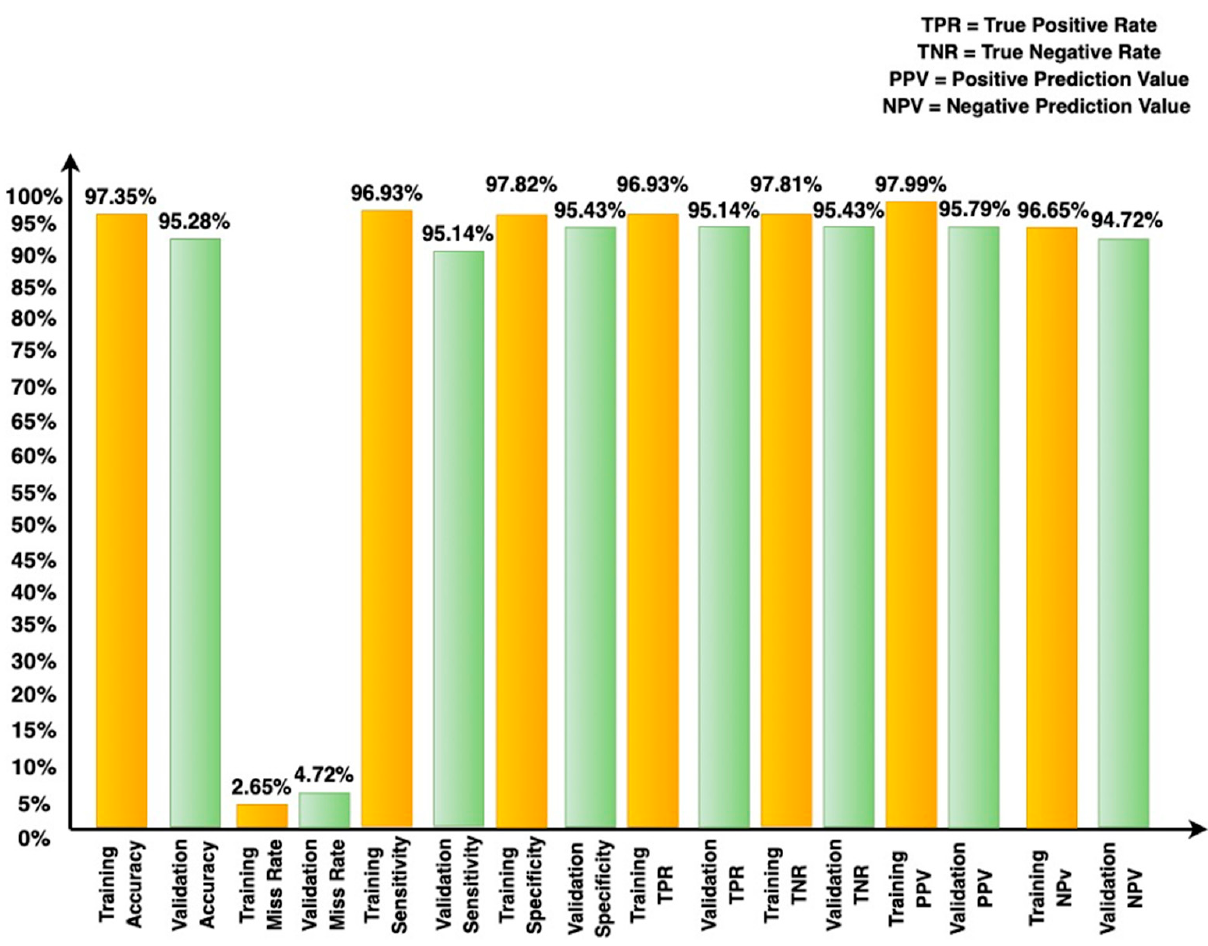
Figure 3. Different statistical measures for the proposed blockchain-based smart home network architecture for the estimation of intrusion with fused dataset during validation and training .